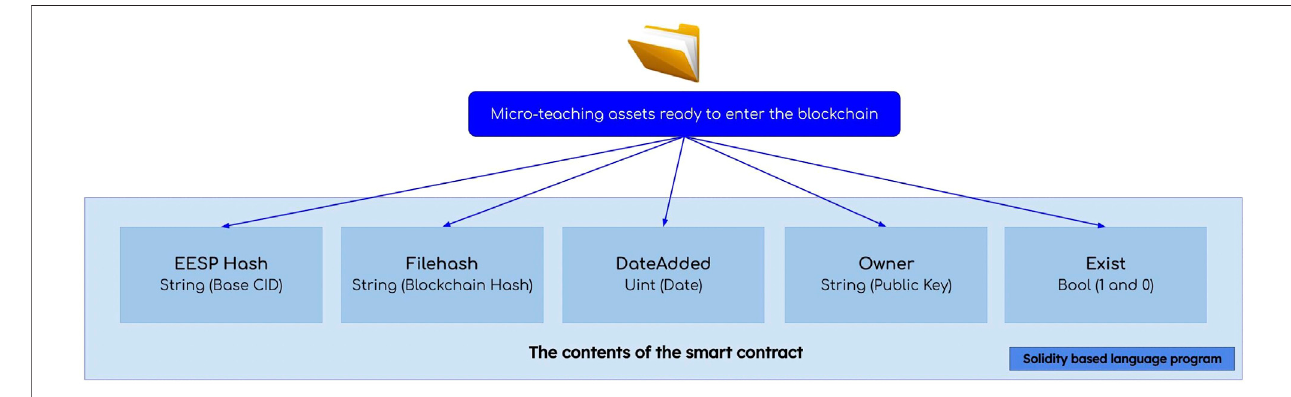
FIGURE 9 | Structure of smart contract